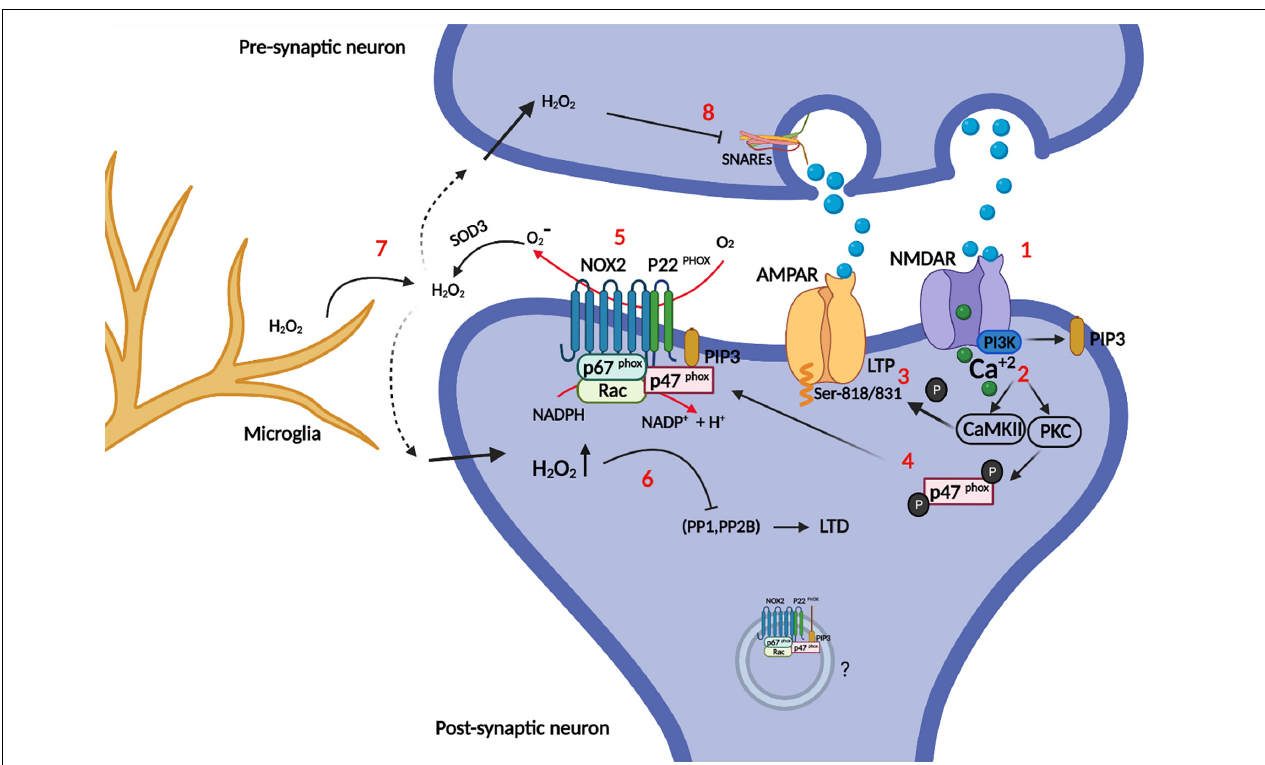
FIGURE 4 | Role of NOX in synapse plasticity. Briefly, synaptic plasticity is governed mainly by LTP: Synapse enhancement through recruitment of AMPA receptors into the post-synaptic membrane and LTD: synapse weakening (AMPA receptors endocytosis). (1) Glutamate binding to NMDARs opens the calcium channel, and activates PI3K directly. (2) Calcium activates CaMKII and PKC (the latter also requires PIP3 as explained in Figure 2 ), which can both (3) phosphorylate AMPARs at specific serines, increasing their conductance and recruitment into the post-synaptic membrane (LTP). Moreover (4) p47 phox is phosphorylated by PKC, which recruits it for complex assembly and activation of NOX2. (5) Enzymatically active NOX2 produces superoxide in the extracellular space, which is cycled back into the cytosol as hydrogen peroxide after dismutation by SOD3. (6) Intracellular hydrogen peroxide potentially redox-regulates phosphatases PP1, and PP2B by oxidation. These phosphatases dephosphorylate AMPARs, promoting their endocytosis and removal from the post-synaptic membrane (LTD). The intra-synaptic pool (depicted inside a vesicle) of NOX2 may be activated differentially from the perisynaptic NOX2 in the plasma membrane and could represent a layer of specificity to redox signaling. (7) NOX2 derived oxidants from microglia may impair instillation of LTP or conversely promote LTD. (8) Hydrogen peroxide can also enter the presynaptic neuron and impair the SNAREs machinery, which is required for synaptic vesicle